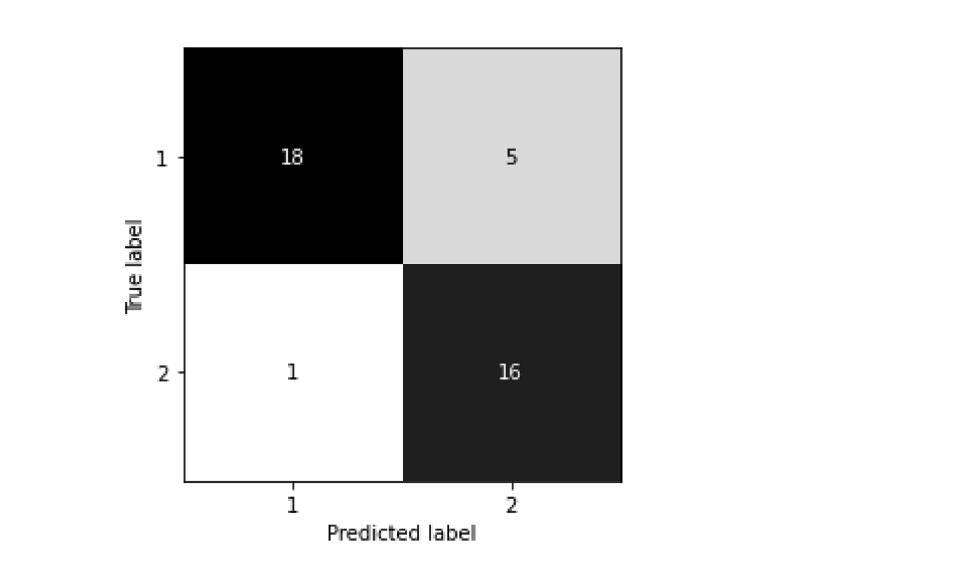
Figure 4. Confusion matrix results based on the random forest model with the SFM feature optimiser (1 for the rare class and 2 for the often